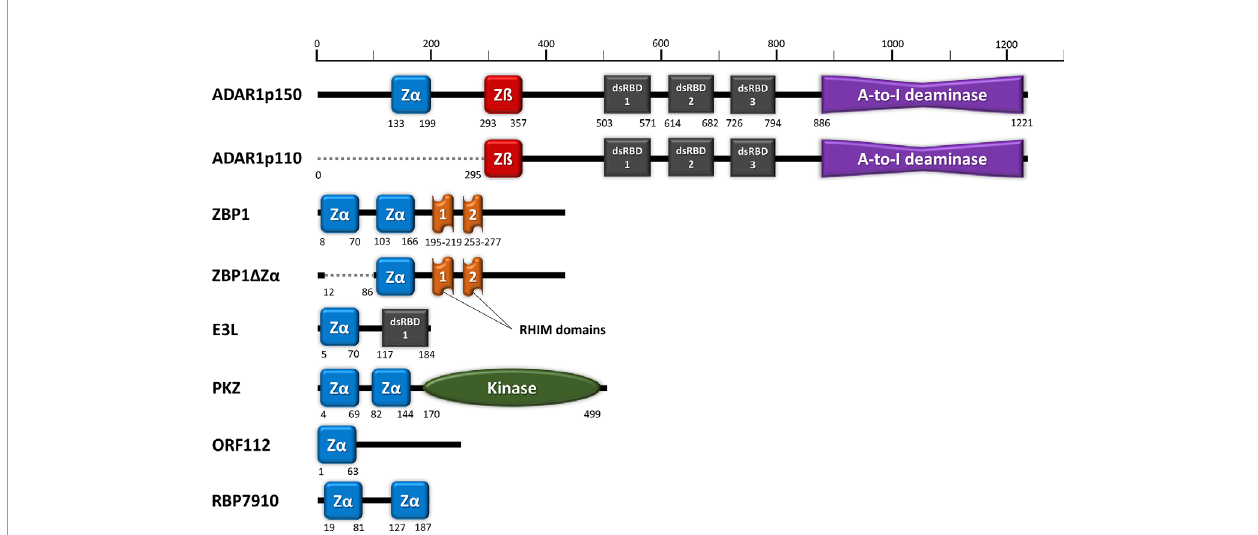
FIGURE 1 | Domain organization of ZDBD-containing proteins: ADAR1, ZBP1, E3L, PKZ, ORF112, and RBP7910. Z a domain (blue) denotes ZDBD that can bind Z-DNA/Z-RNA, while Zß domain (red) denotes ZDBD that cannot bind Z-DNA/Z-RNA. ADAR1 p150 harbors an extra Z a domain compared to ADAR1 p110 , while sharing identical dsRNA binding domains (dsRBDs) and catalytic deaminase domain. Two natural isoforms were also described for ZBP1, where ZBP1Z D does not contain the fi rst Z a domain present in full length ZBP1. Vaccinia virus E3L vital for its pathogenicity contains a single Z a domain and a dsRBD. Fish PKZ contains two N-terminal Z a domains as the RNA recognition motifs, in addition to a C-terminal kinase domain. On the other hand, the ORF112 protein identi fi ed from fi sh herpesvirus only has a single Z a domain at its amino-end. Most recently, trypanosome RBP7910 protein has been reported to contain two Z a -like domains, although further characterization of their function may be